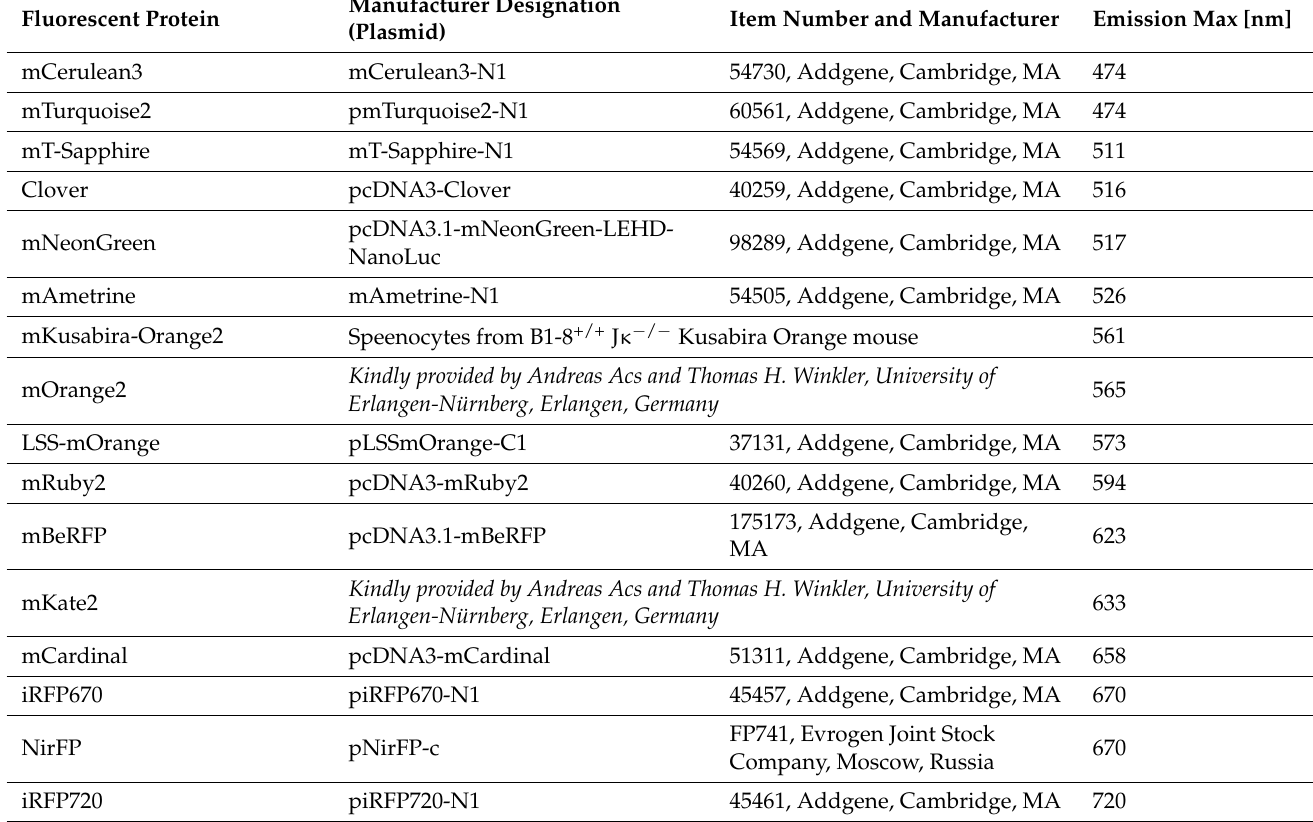
Table 2. Plasmid manufacturer/transgenic mouse of the investigated fluorescent proteins with maximum of emission